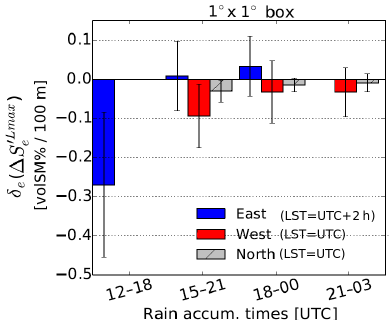
Figure 8. Value of the spatial coupling measure δ e calculated for various afternoon rainfall accumulation times, and averaged over selected domains, i.e east (6–10 ◦ N, 24–34 ◦ E), west (7–12 ◦ N, 8 ◦ W–6 ◦ E) and north (14–17 ◦ N, 7–14 ◦ E). Locations of the do- mains are shown in Fig. 4. Error bars indicate one SD of δ e values in every domain. Note that all times are indicated in UTC.